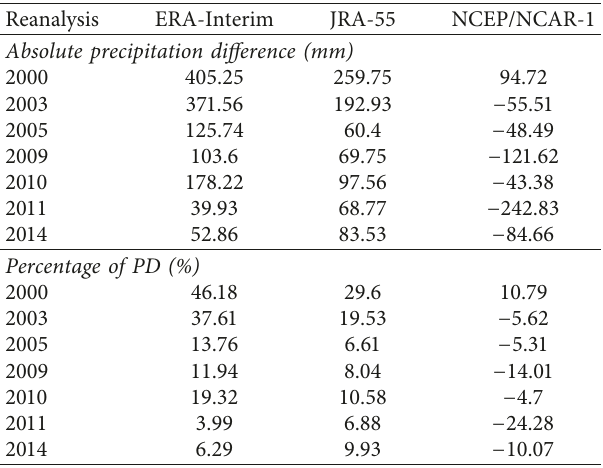
Table 5: The PDs and PPDs between ERA-Interim, JRA-55, and NCEP/NCAR-1 and observed precipitation for the wet years.